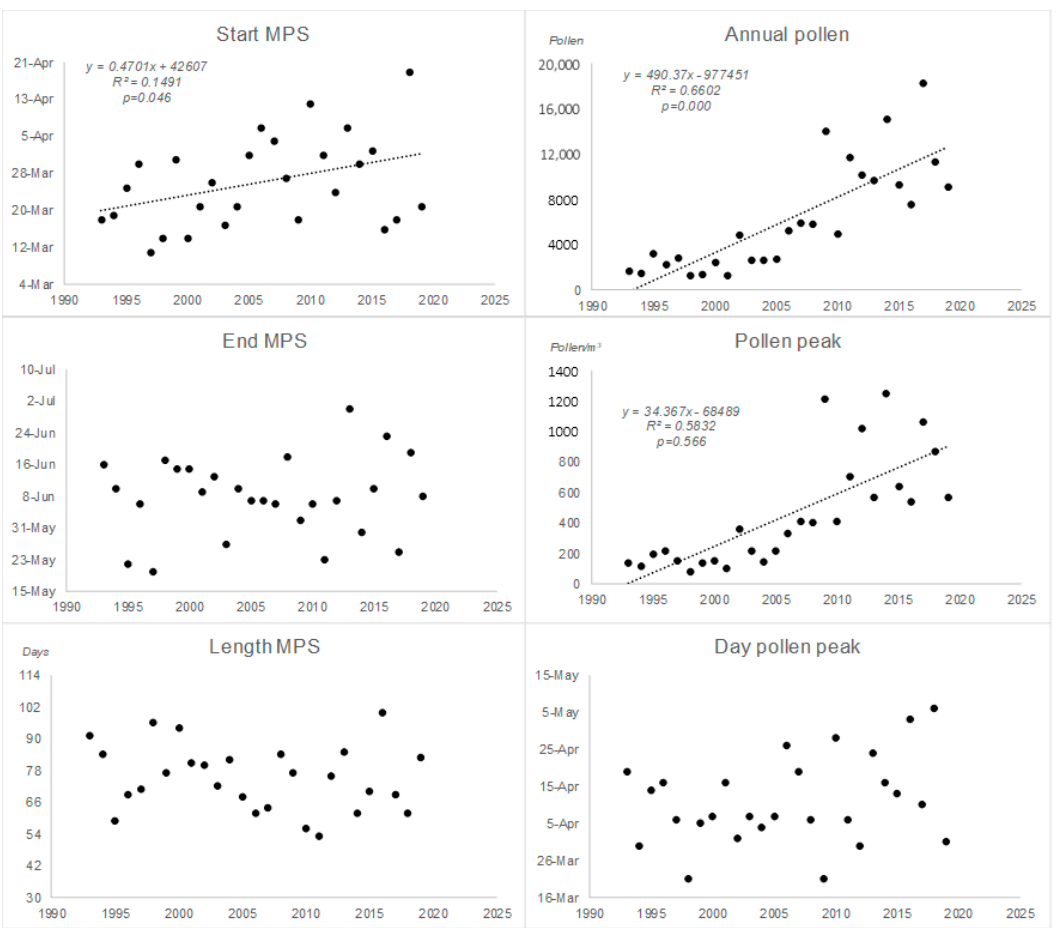
Figure 5. Trends of the airborne Quercus Main Pollen Season (MPS) characteristics during the 27 years of the study: start date, end date, length, annual pollen integral, daily pollen peak and its date.